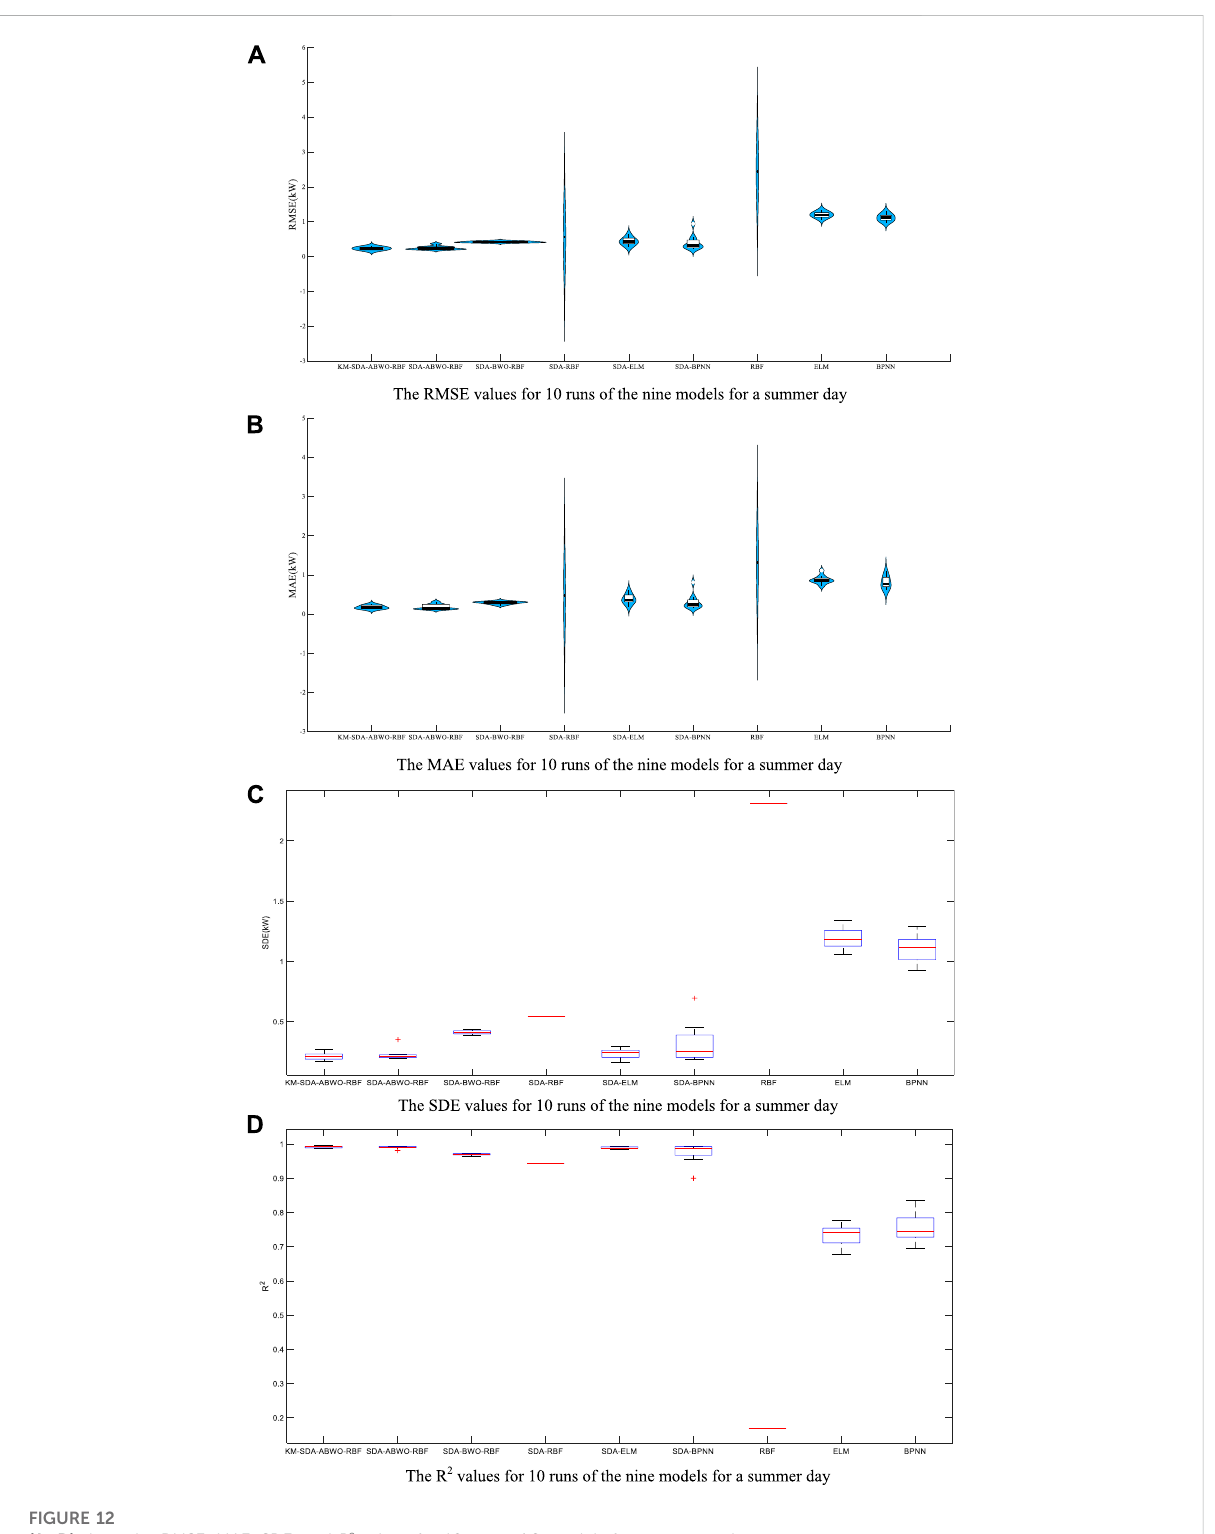
FIGURE 12 (A – D) show the RMSE, MAE, SDE, and R 2 values for 10 runs of 9 models for a summer